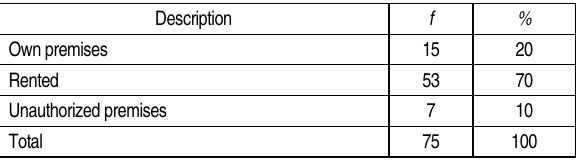
Table 4. Variation of premises ownership